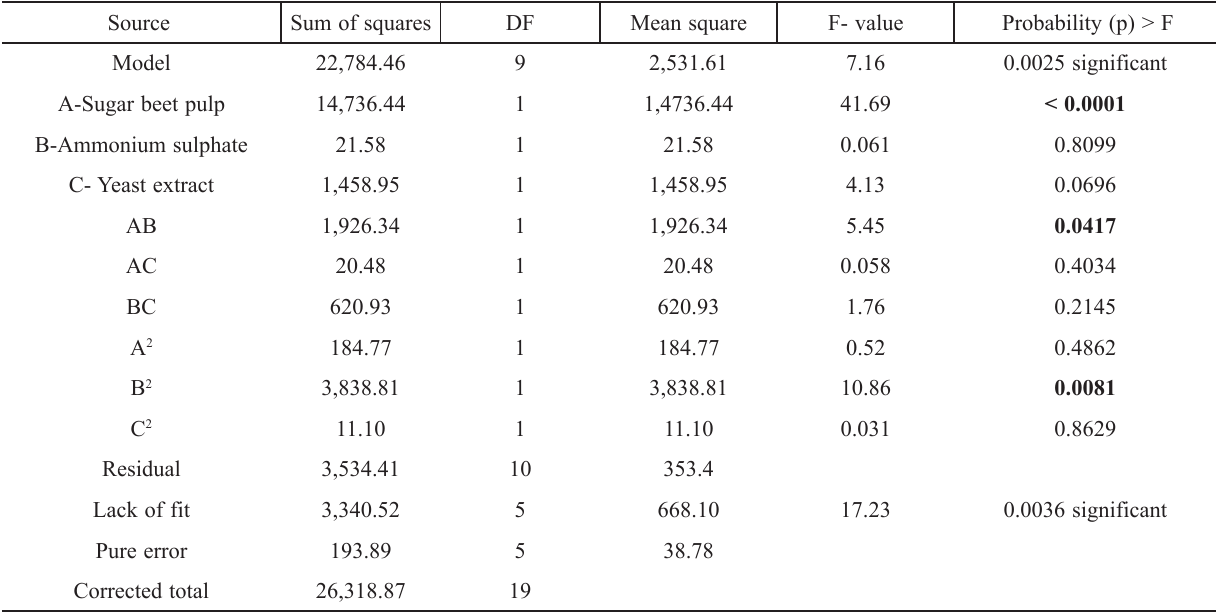
Table 3 – Analysis of variance (ANOVA) for a quadratic polynomial (quadratic) model of endo-pectinase activity as a function of medium